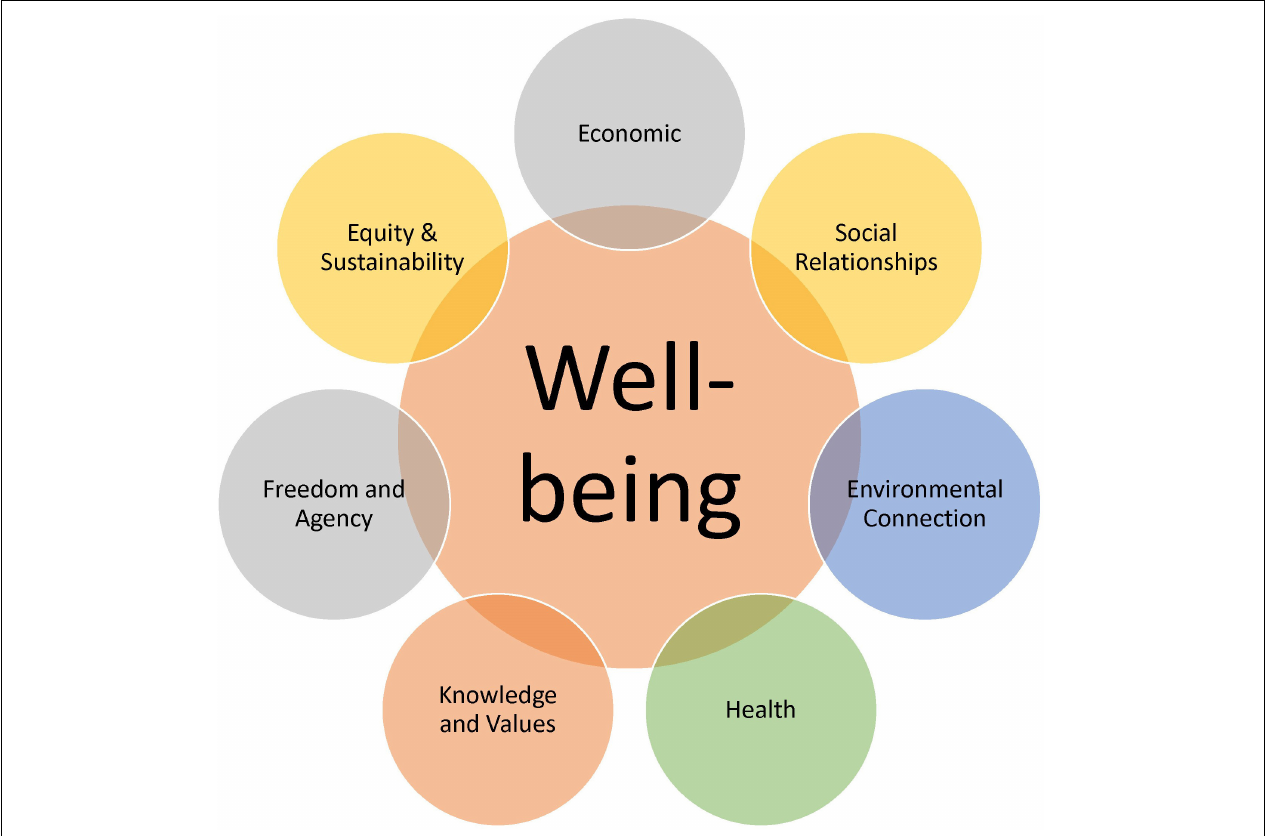
FIGURE 2 | Elements of well-being that are explored in the QNMs of adaptive behaviors to small sablefish abundance and whale